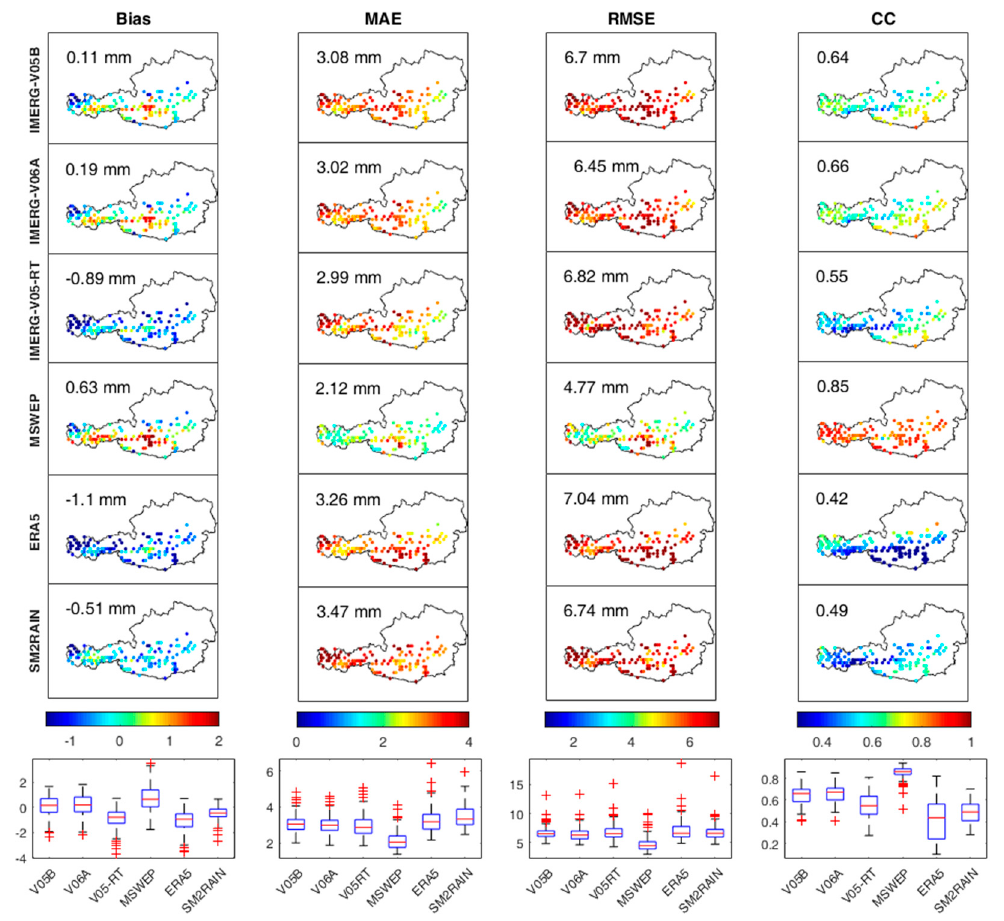
Figure 7. Spatial distributions and box plots of the statistical indices for the precipitation products and stations with the elevation greater than 1000 m. The center-line of each boxplot depicts the median value (50th percentile) and the box encompasses the 25th and 75th percentiles of the sample data, while the whiskers represent the extreme values, respectively.